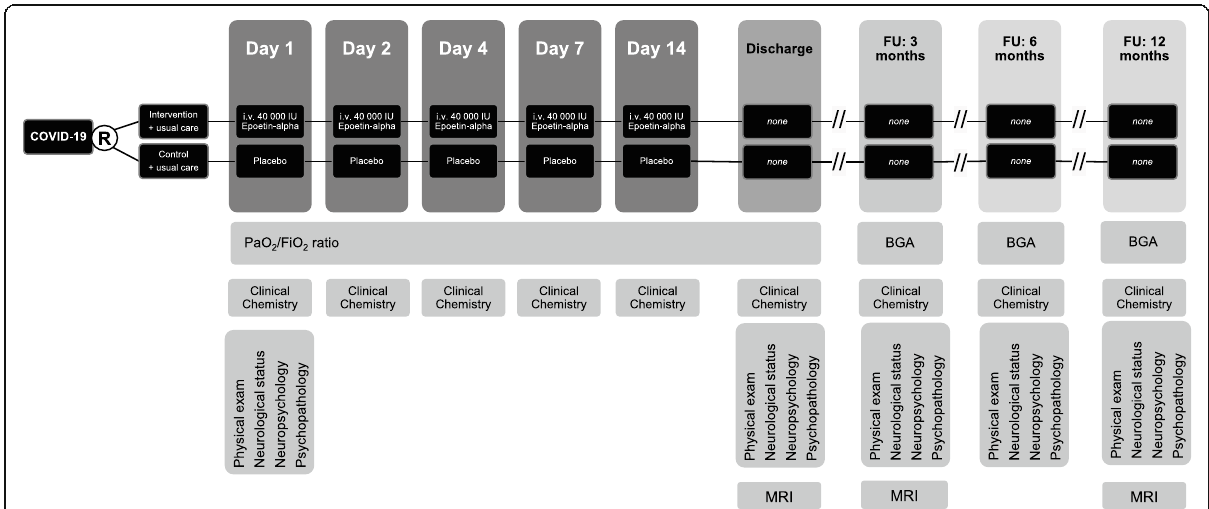
Fig. 2 Design of a double-blind, placebo-controlled, randomized proof-of-concept trial (phase IIb) on EPO treatment in severely affected COVID- 19 patients. Patients receive 40,000 IU recombinant human erythropoietin (EPO) or placebo plus standard care on the first day of mechanical ventilation (day 1), as well as on days 2, 4, 7 and 14. Pulmonary function and laboratory work-up including inflammatory parameters are monitored throughout in-hospital treatment, as well as on follow-up examinations at 3, 6 and 12 months after discharge. At discharge and after 3 and 12 months, magnetic resonance imaging (MRI) and spectroscopy (MRS) of the brain take place. BGA = blood gas analysis, FU =